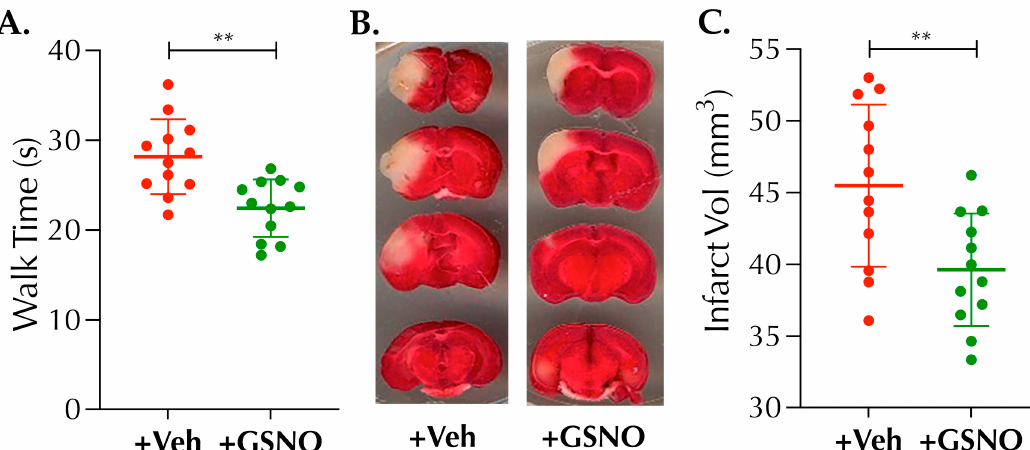
Figure 3. Nebulization of GSNO improves behavioral outcomes and attenuates thrombotic stroke injury in diabetic mice. Diabetic male mice (C57/B6 background, 14 ±1 ‐ wks. old) were subjected to PT ‐ stroke and treated with Veh or GSNO as described in Figure 1. Behavioral assessment on beam ‐ walk test (BWT) and absolute infarct volume (in mm 3 ) /stroke injury analyses were performed at 48 h post ‐ stroke. ( A ) GSNO nebulization (100 µ g/kgbwt × 2 doses at 2 h and 6 h post-stroke) significantly improved the behavioral outcomes in +GSNO group as compared to the +Veh group (**, p = 0.0011). Moreover, ( B , C ) GSNO nebulization was also significantly effective in preventing the infarct progression in +GSNO group as compared to +Veh controls (**, p = 0.0074). Data are presented as Mean ± SD ( n = 12 mice/group). Statistical significance was determined at p < 0.05 and using an unpaired t-test . No mortalities were observed by the end of this experiment at 48 h, as rarely seen in this mini ‐ infarct model of PT ‐ stroke.